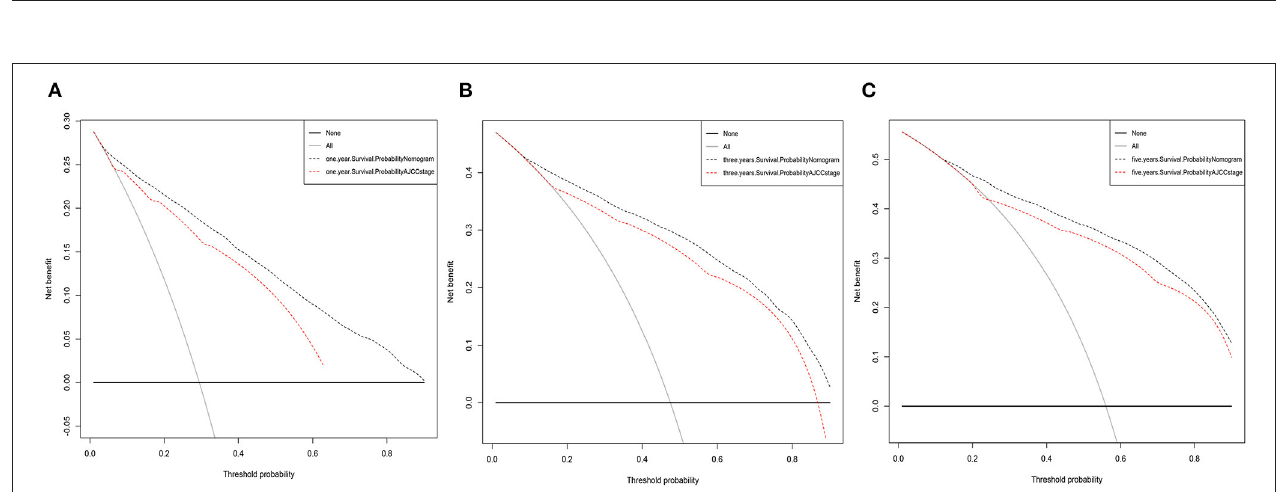
FIGURE 5 | ROC curves and calibration plots for predicting patients-specific survival at 1-, 3-, and 5-year in the validation cohorts. (A) ROC curves of the Nomogram and AJCC stage in prediction of prognosis at 1-, 3-, and 5-year point in the validation cohorts. (B) The calibration plots for predicting patient survival at 1-, 3-, and 5-year point in the validation cohorts. ROC, receiver operating characteristic curve; AUC, areas under the ROC curve.